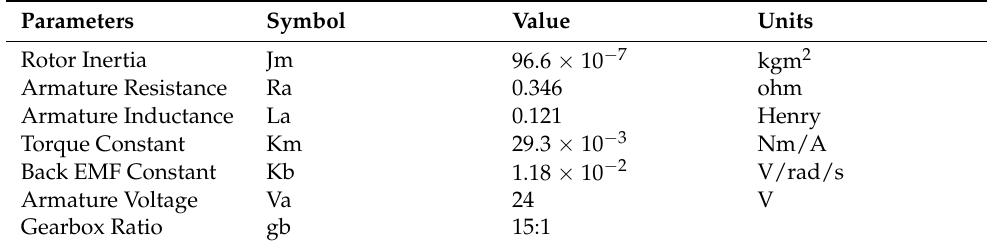
Table 5. Parameters of DC